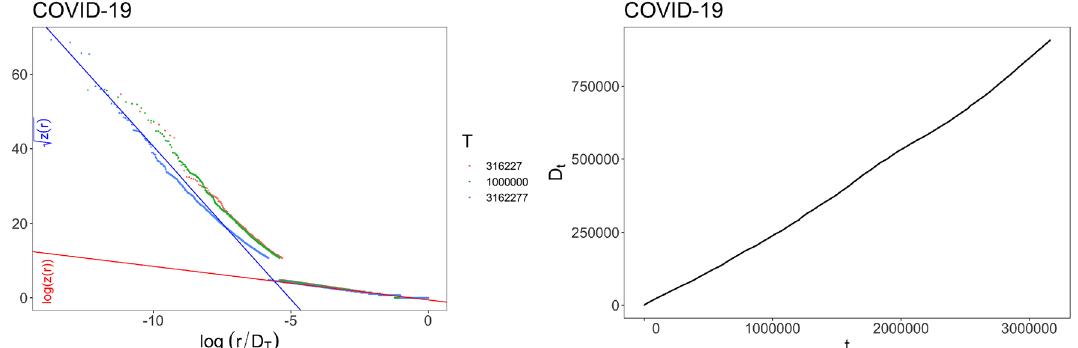
and log- ∗ 7.44, 6.80 8.68 , a 2 0.895 , R , that − ] = = ∗ ∈ [−